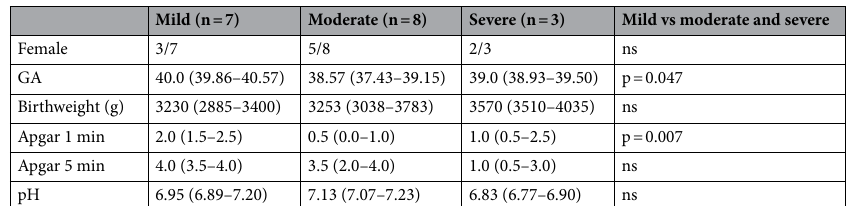
Table 1. Patient details. Median values are reported per outcome group and the inter-quartile range is indicated between brackets. The p-value is the Mann–Whitney U test comparing to the mild group to the pooled moderate and severe group. ns = not significant. GA: gestational age in weeks, Apgar: standardised clinical assessment of the neonate directly after birth. Low scores indicate abnormal conditions.